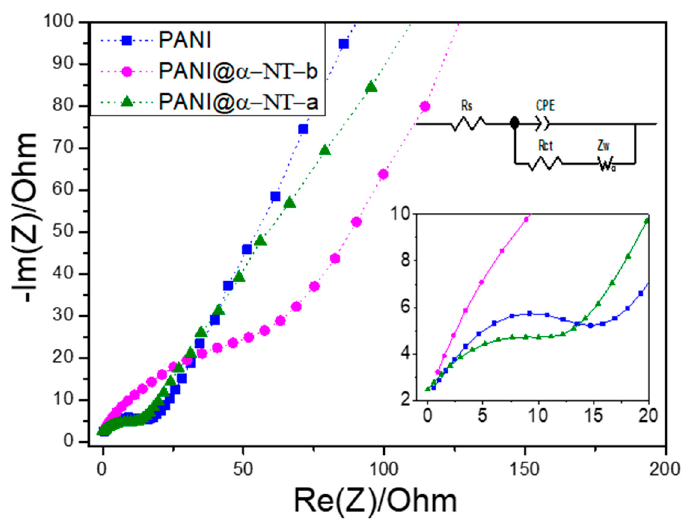
Figure 6. Nyquist electrochemical impedance spectra of PANI@ α -NT-a, PANI@ α -NT-b and PANI electrodes (inset: the enlarged high frequency region) .